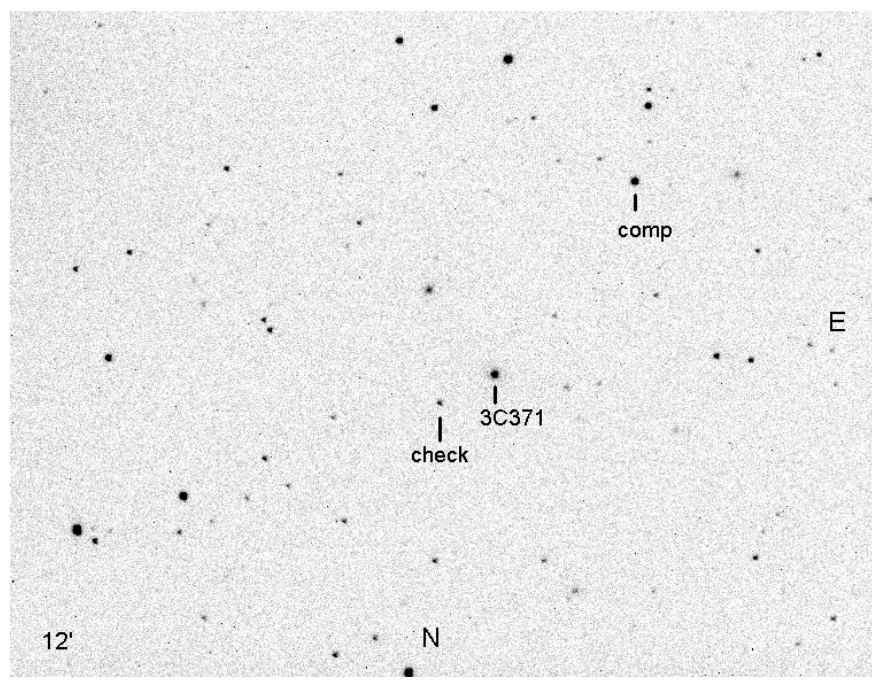
Figure 8. Neighborhoods of BL Lac object 3C 371, the figure also shows the comparison star and the checking star, as well as the directions to the North and East. checking star, as well as the directions to the North and